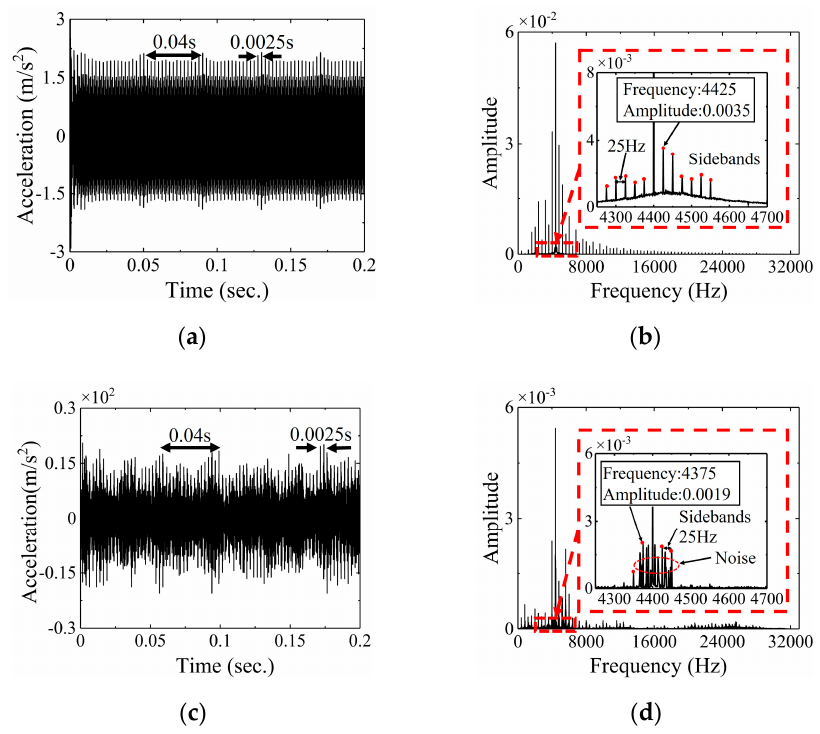
Figure 12. The simulated and experimental signal along the line of action (adjacent teeth spalling fault): ( a ) simulated signal, ( b ) simulated frequency signal, ( c ) experimental signal, and ( d ) experimental frequency signal.